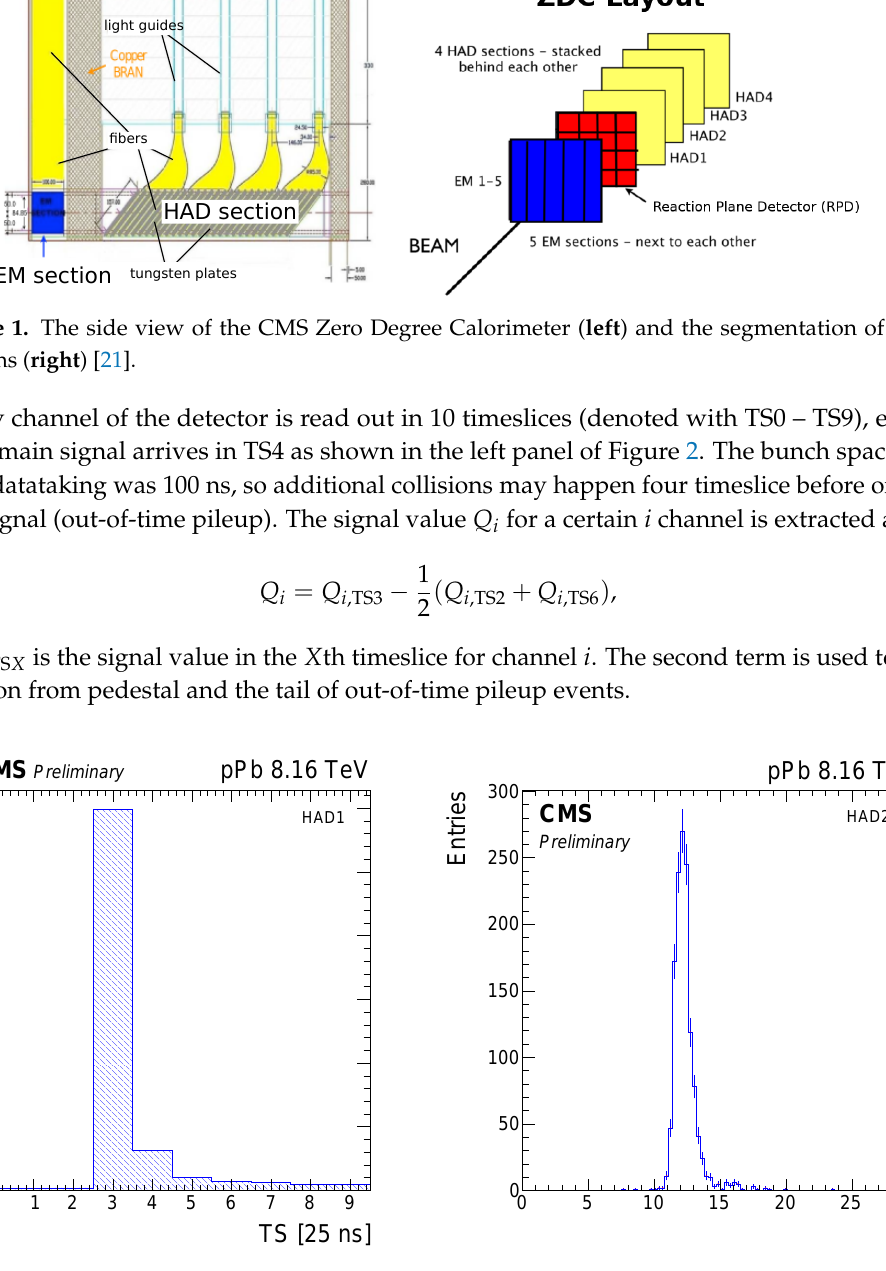
Figure 2. The time dependence of the Zero Degree Calorimeters (ZDC) signal ( left ) and the distribution of TS4 and TS5 signal ratio ( right )